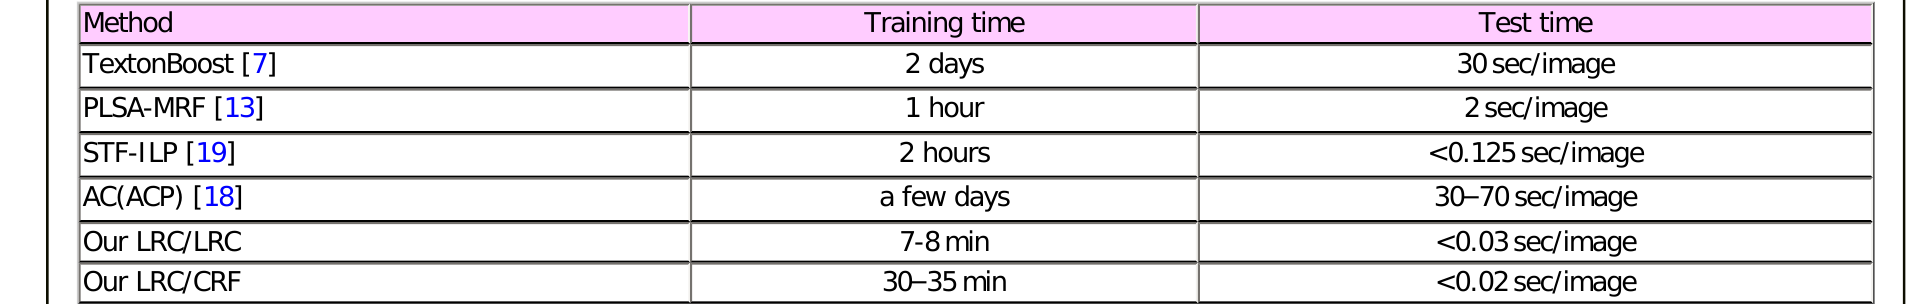
Table 3 Reported training and testing times for various algorithms on MSRC-21.